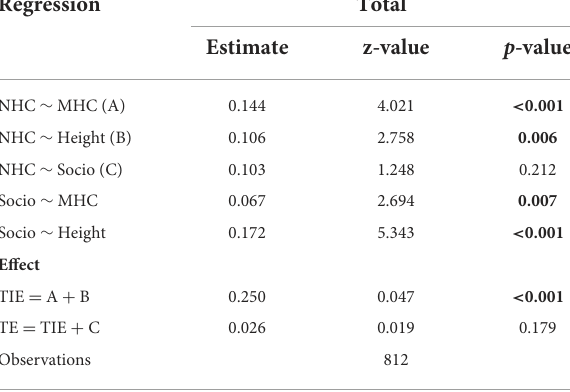
TABLE 3 Regression parameters from “Path Analysis” using latent variables and defined